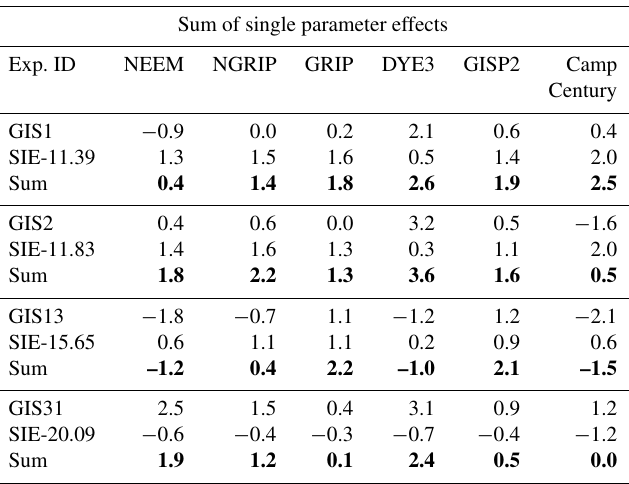
Table B1. Simulated δ 18 O p anomalies compared to 125ka control on six Greenland deep ice cores: NEEM, NGRIP, GRIP, DYE3, GISP2 and Camp Century. For each pair of simulations, δ 18 O p anomalies due to (1) GIS shape changes, (2) sea ice changes and (3) sum of single parameter effects are shown (numbers in bold font).